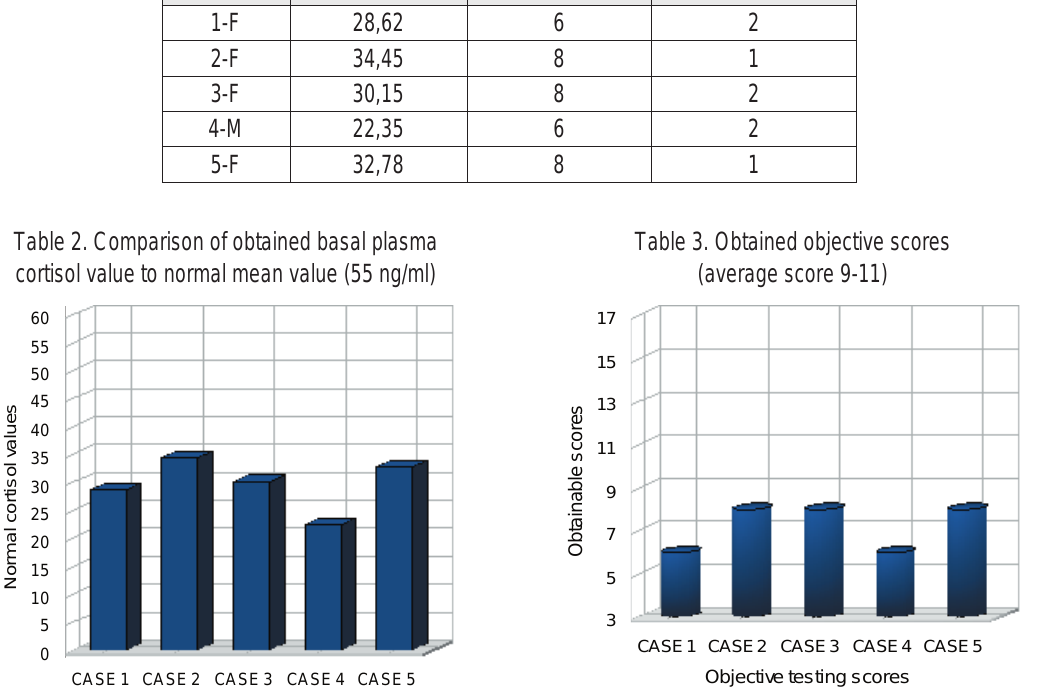
Table 3. Obtained objective scores (average score